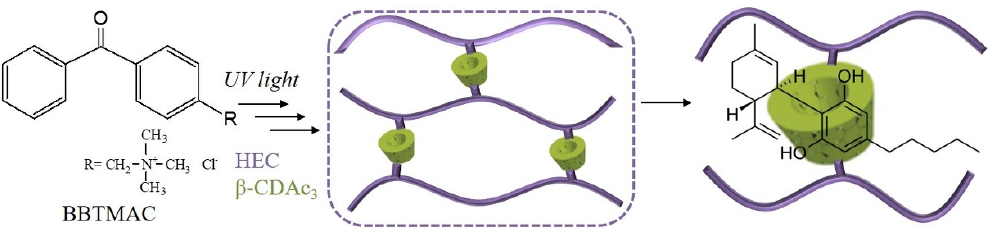
Figure 2. Formation of HEC/β-CD polymer network and “host-guest” complex between β-CD and CBD.